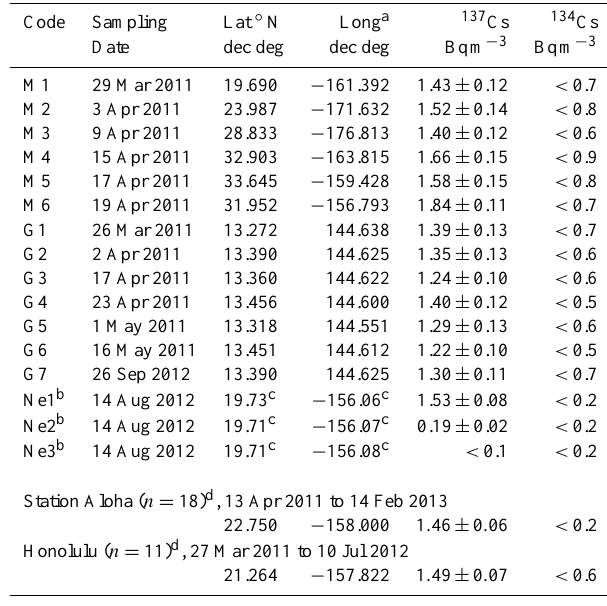
c Estimated from offshore pipe length. d Individual results of 137 Cs activities presented in Fig. 2.